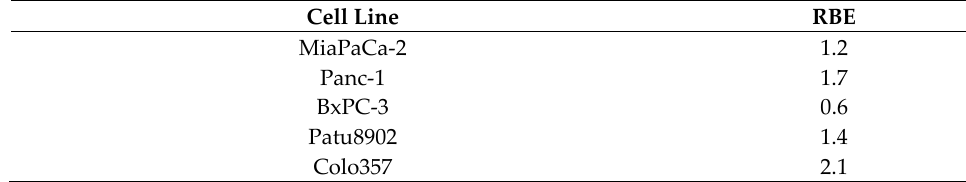
Figure S6. Targeting NHEJ-associated enzymes seems generally potent to sensitize 3D PDAC cell cultures to photon and proton irradiation. Three-dimensional tumoroid formation capacity upon 1- h inhibitor pretreatment combined with 6-Gy photon or proton irradiation. All results show mean ± SD ( n = 3; two-sided t test; *, p < 0.05; **, p < 0.01; ***, p < 0.001). Table S1. RBE values comparing proton to photon irradiation effectiveness in PDAC cell lines.